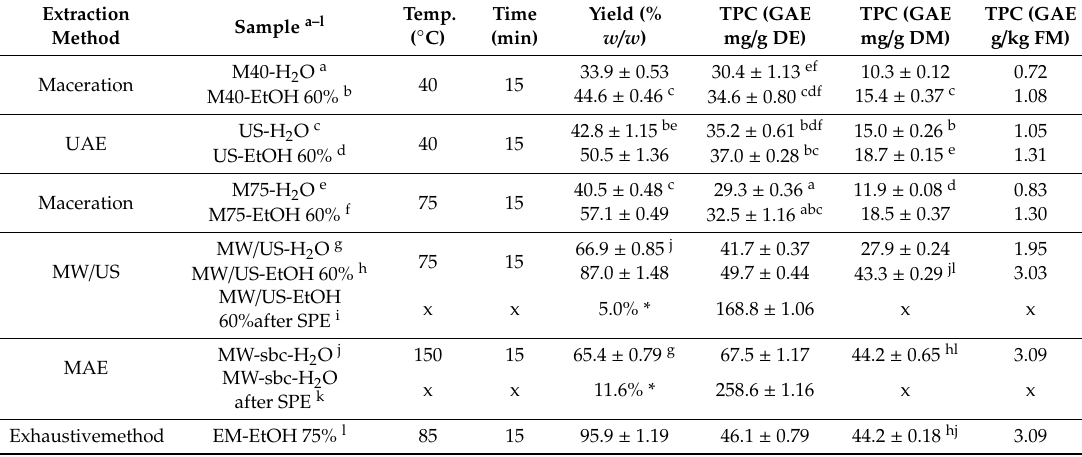
Table 1. Extraction yields expressed as a w / w percentage over dried matrix (DM); total phenolic content, expressed as GAE mg / g DE, GAE mg / g DM and GAE g / kg FM, obtained using di ff erent extraction